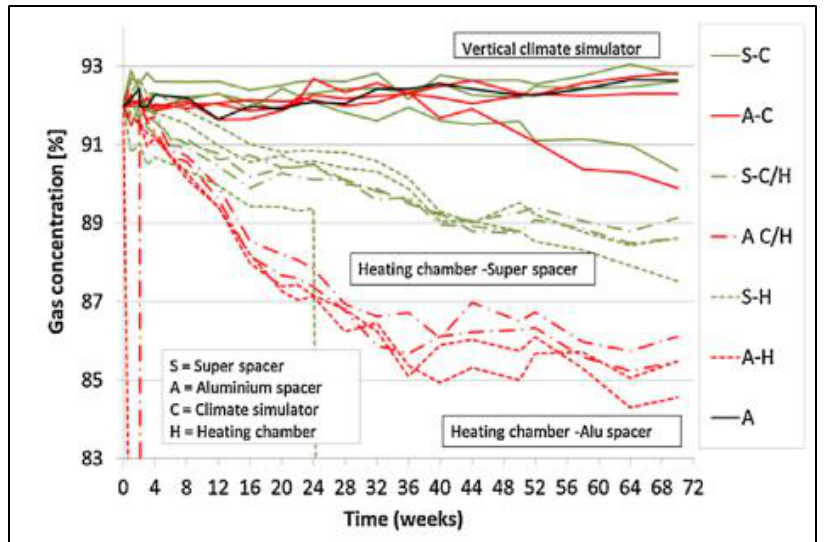
Figure 9. Gas Concentration Versus Time of the Windowpanes Subjected to Accelerated Aging [5].